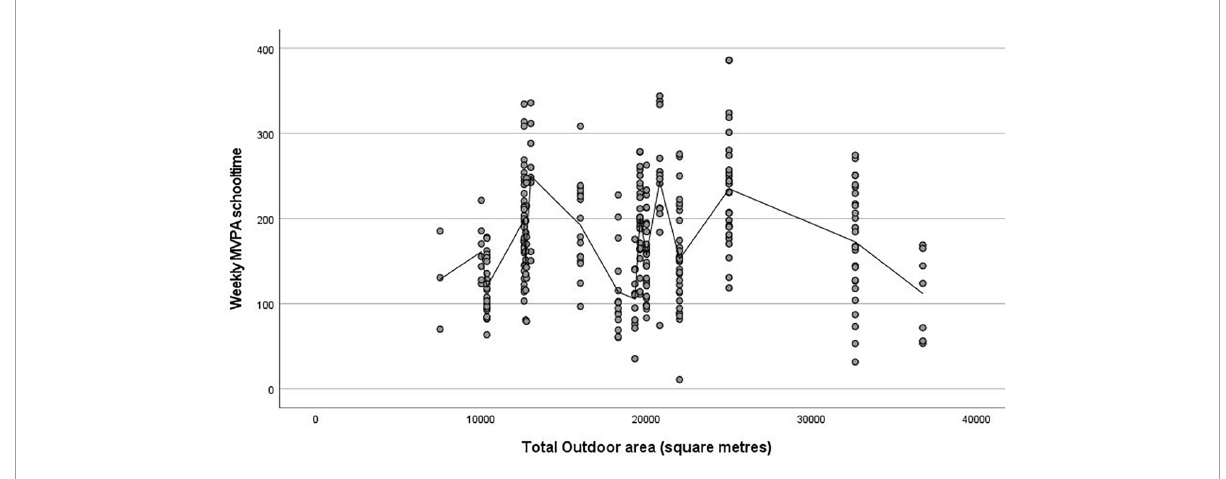
FIGURE1 Scatter diagram showing the schools’ total outdoor area (in square meters) along the X -axis and the pupils’ weekly MVPA along the Y -axis ( p ≤ 0.05).